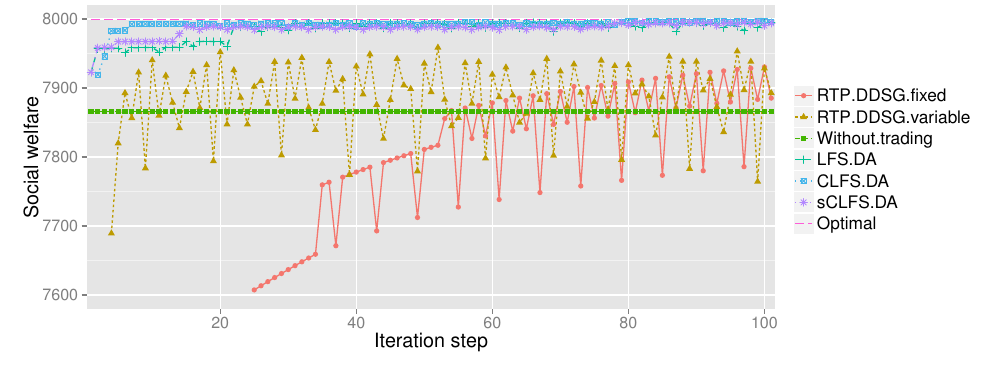
Figure 3. Social welfare after iterations with each method.